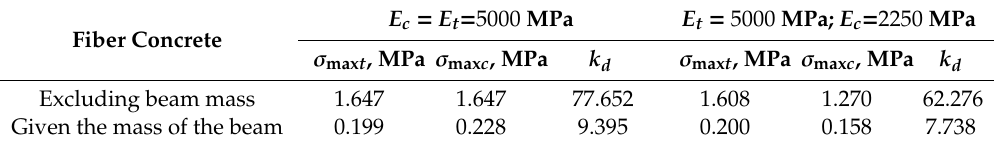
Table 6. The maximum dynamic normal stresses when the bars are located only in the stretched